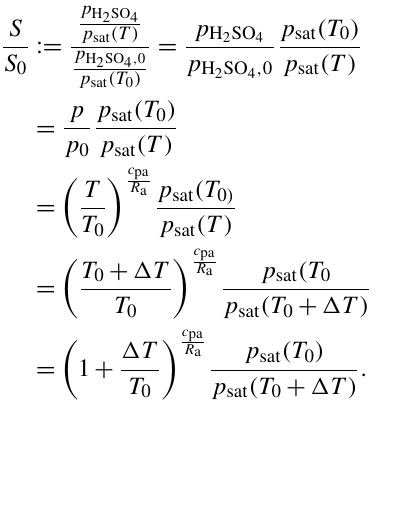
(i.e. the factorial in- Figure C1 exhibits the quotient S S 0 crease in the saturation ratio S in reference to an initial satu- ration ratio S 0 at undisturbed conditions, including supersat- urated states) for several initial states of ambient air temper- ature T 0 (from 185 to 250 K) and for a range of temperature anomalies with (cid:49)T of up to 4 K. It is to be emphasised that these calculations relate specifically to the impact of temper- ature anomalies on the supersaturation of pure H 2 SO 4 . These estimates based on ordinary precursors (i.e. H 2 SO 4 –H 2 O) do not allow for conclusions concerning the NPF efficiency of complex systems of precursor compositions (e.g. includ- ing ammonia or organics). The demonstrated effect, however, is qualitatively transferable to any gaseous substance, while the nucleation of particles from the gas phase requires suffi- ciently high saturation ratios of the respective species or gas mixture and may be of particular interest in the context of the CLOUD experiments at CERN with H 2 SO 4 (cf. Stolzenburg et al., 2020) under variable conditions and various admix-